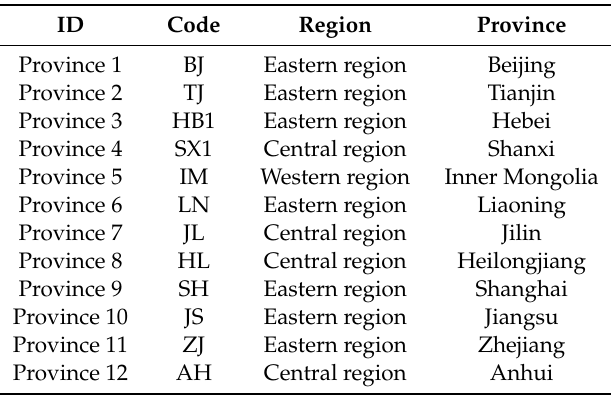
Table 2. Codes for